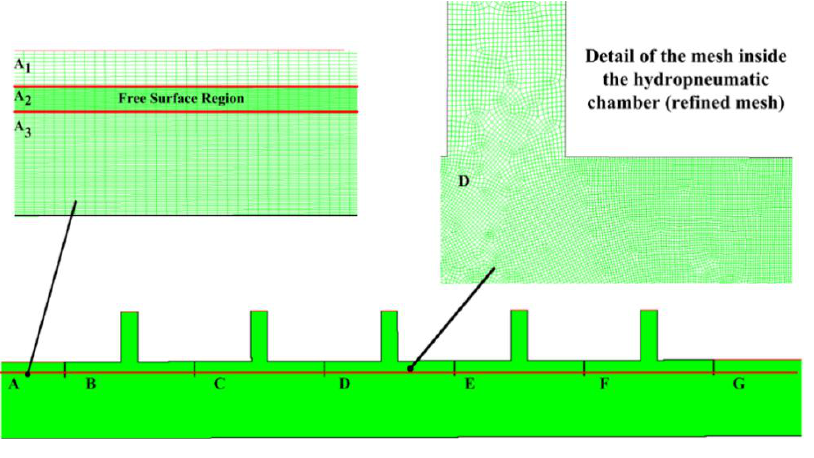
Figure 5. Spatial discretization of the computational domain. Squares of 0.1 m in length totaling 620 horizontal volumes were used for the devices’ region, while squares of 1 m in length were used for the regions outside the devices, as recommended by Gomes [37]. The region G represents the geometry after the devices and has 200 horizontal volumes and the same vertical discretization of region